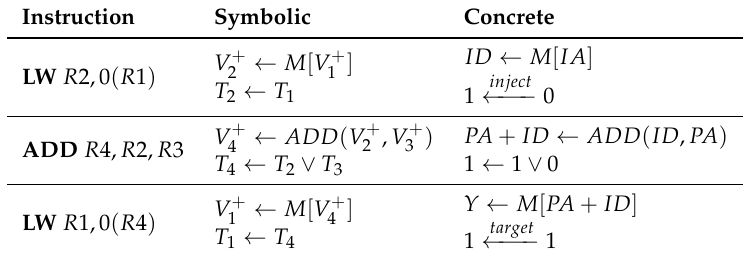
Table 3. Our model applied to a real use case: a basic implementation of Spectre/Meltdown.